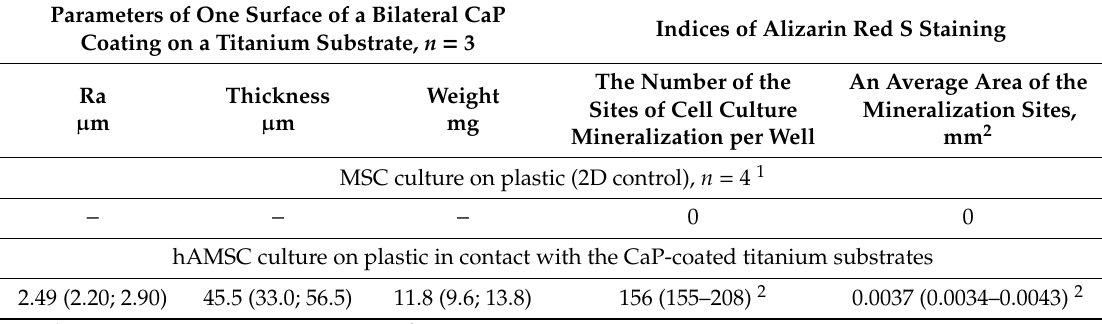
Table 2. Osteogenic di ff erentiation of hAMSCs on plastic after 21 days of in vitro coculture with the microarc CaP-coated titanium substrates, Me